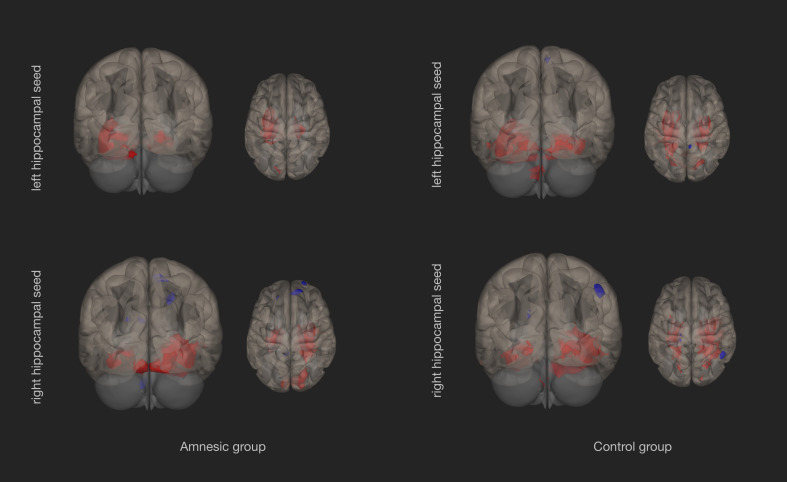
Left and right hippocampal seed-to-voxel functional connectivity, as a function of group.Left panel: in the amnesic group, functional connectivity of the left hippocampal seed region with the rest of the brain was associated with significant activity in two clusters, whereas the right hippocampal seed was associated with significant activity in seven clusters. Right panel: in the control group, functional connectivity with the left hippocampal seed region was associated with significant activity in three clusters, whereas the right hippocampal seed was associated with significant activity in nine clusters. 3-D rendered brains depict activity at a cluster-size p-FDR threshold set at <0.05 and height threshold set at p-uncorrected <0.001 (two-sided) (see Supplementary file 1p).